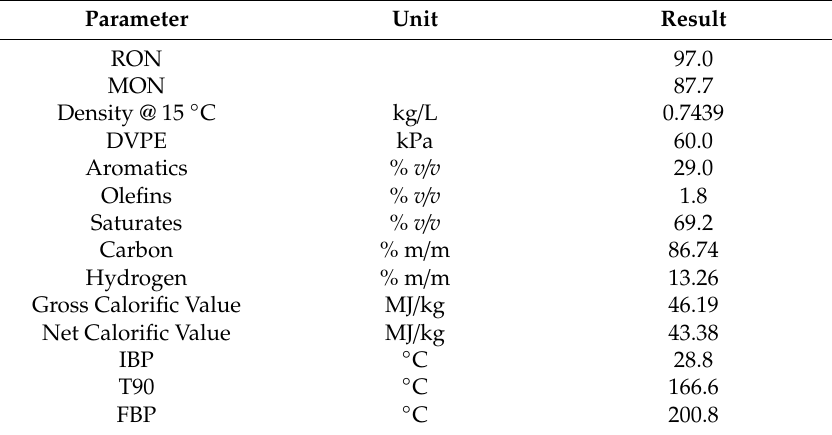
Table 7. Composition of the base CEC RF-02-03 gasoline test fuel.